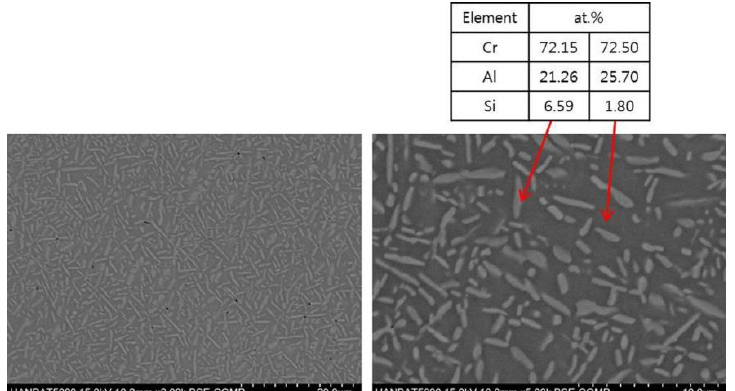
Figure 4. SEM-EDS analyses of isothermally heated Cr–xAl–5%Si alloys (2000X): ( a ) 5% Al, ( b ) 10% Al.